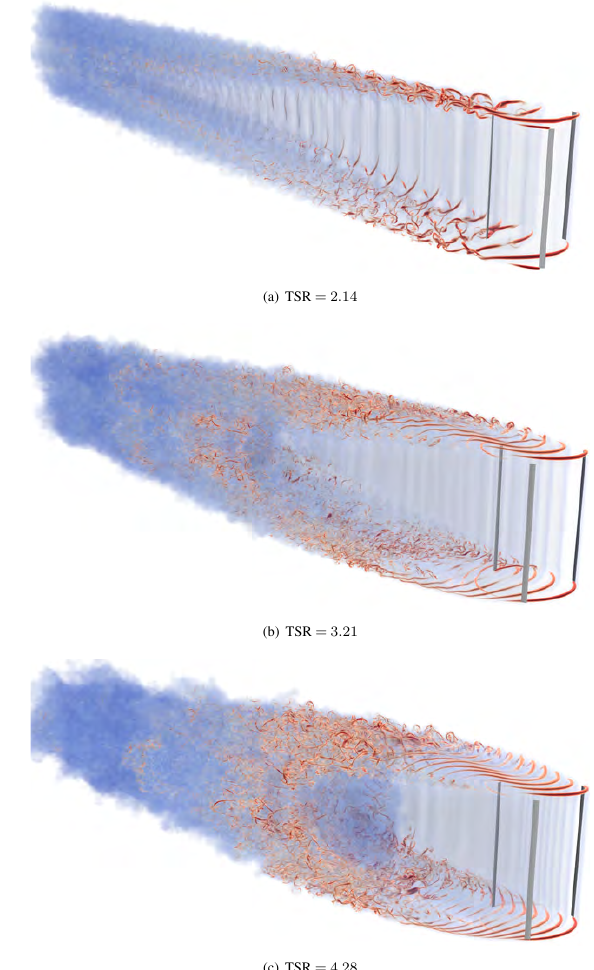
Figure 4. H-type VAWT with AR = 1 . 5: volume rendering of the vorticity magnitude (cid:107) ω (cid:107) ; the lifting lines are also shown as 3-D blades.